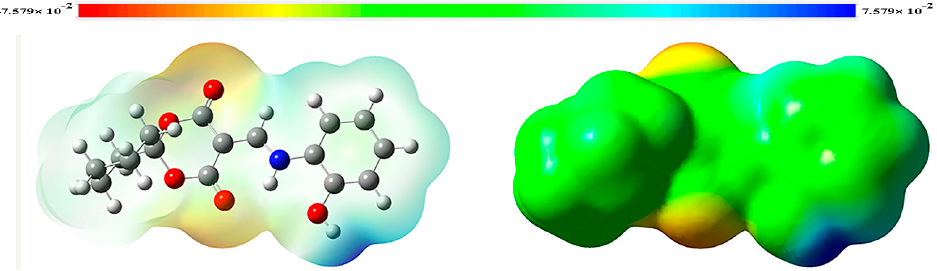
Figure 7. The molecular electrostatic potential for HMD.